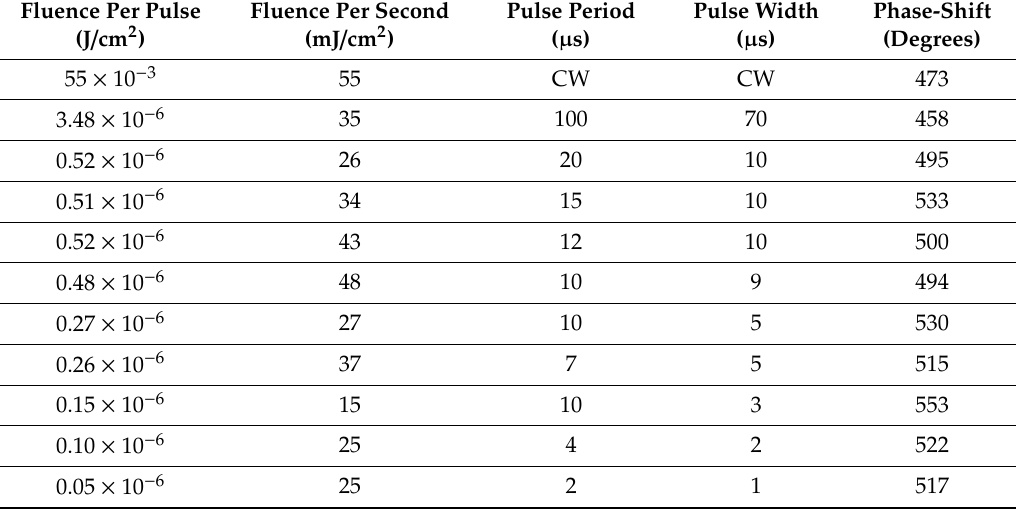
Table 1. Polymer phase-shift after continuous wave (CW) irradiation and after pulsed irradiation as a function of pulse period, pulse width and pulse